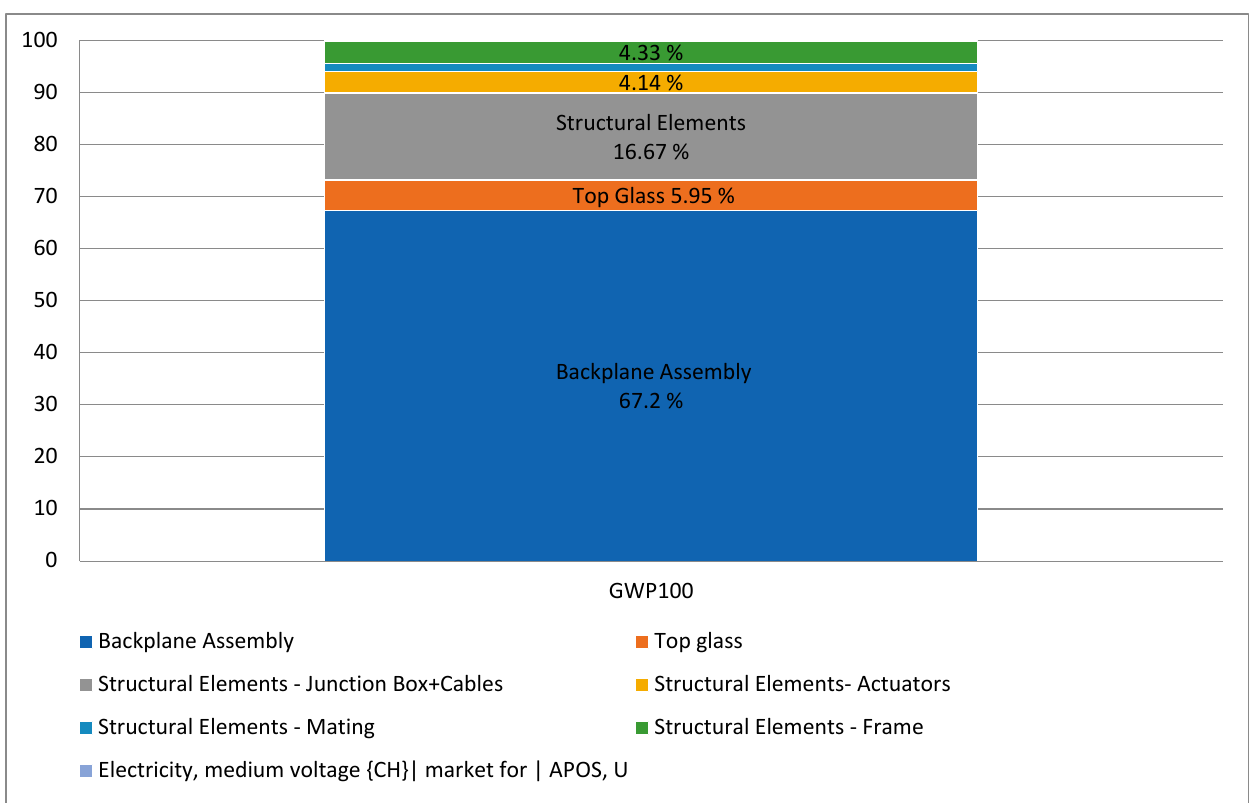
Figure 7. Percentage share of the HIPERION module system components.